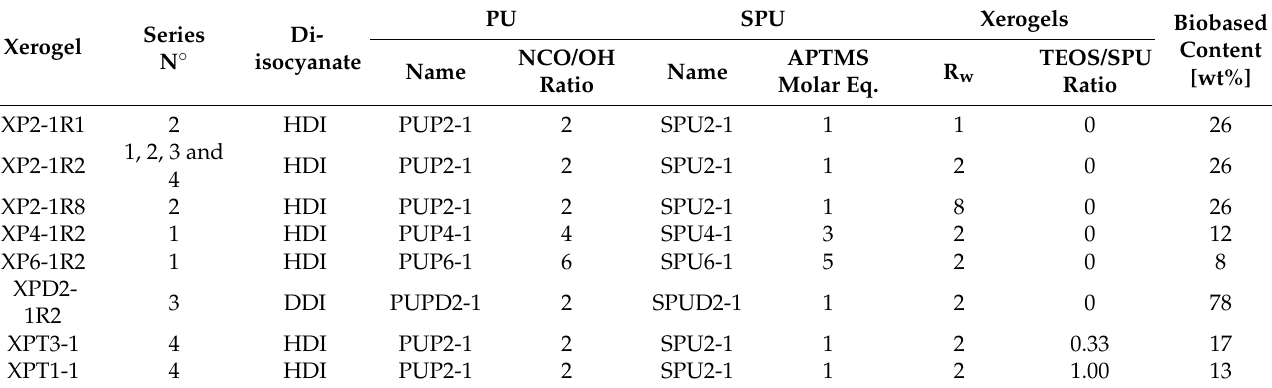
Scheme 2. Synthetic pathway for the synthesis of the SPUs. Table 1. Compositions of the xerogels.